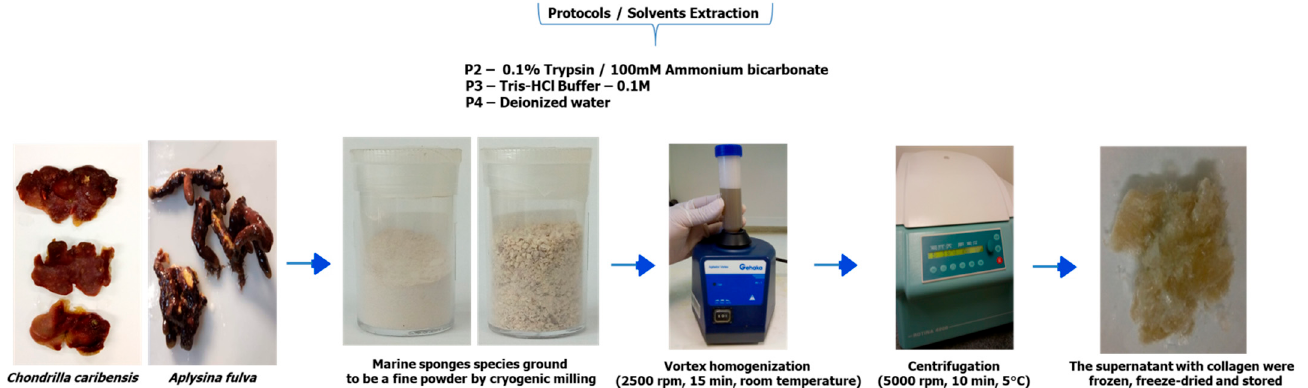
Figure 1. Summary of SC extraction methodology for C. caribensis and A. fulva for protocols 2, 3, and 4 .